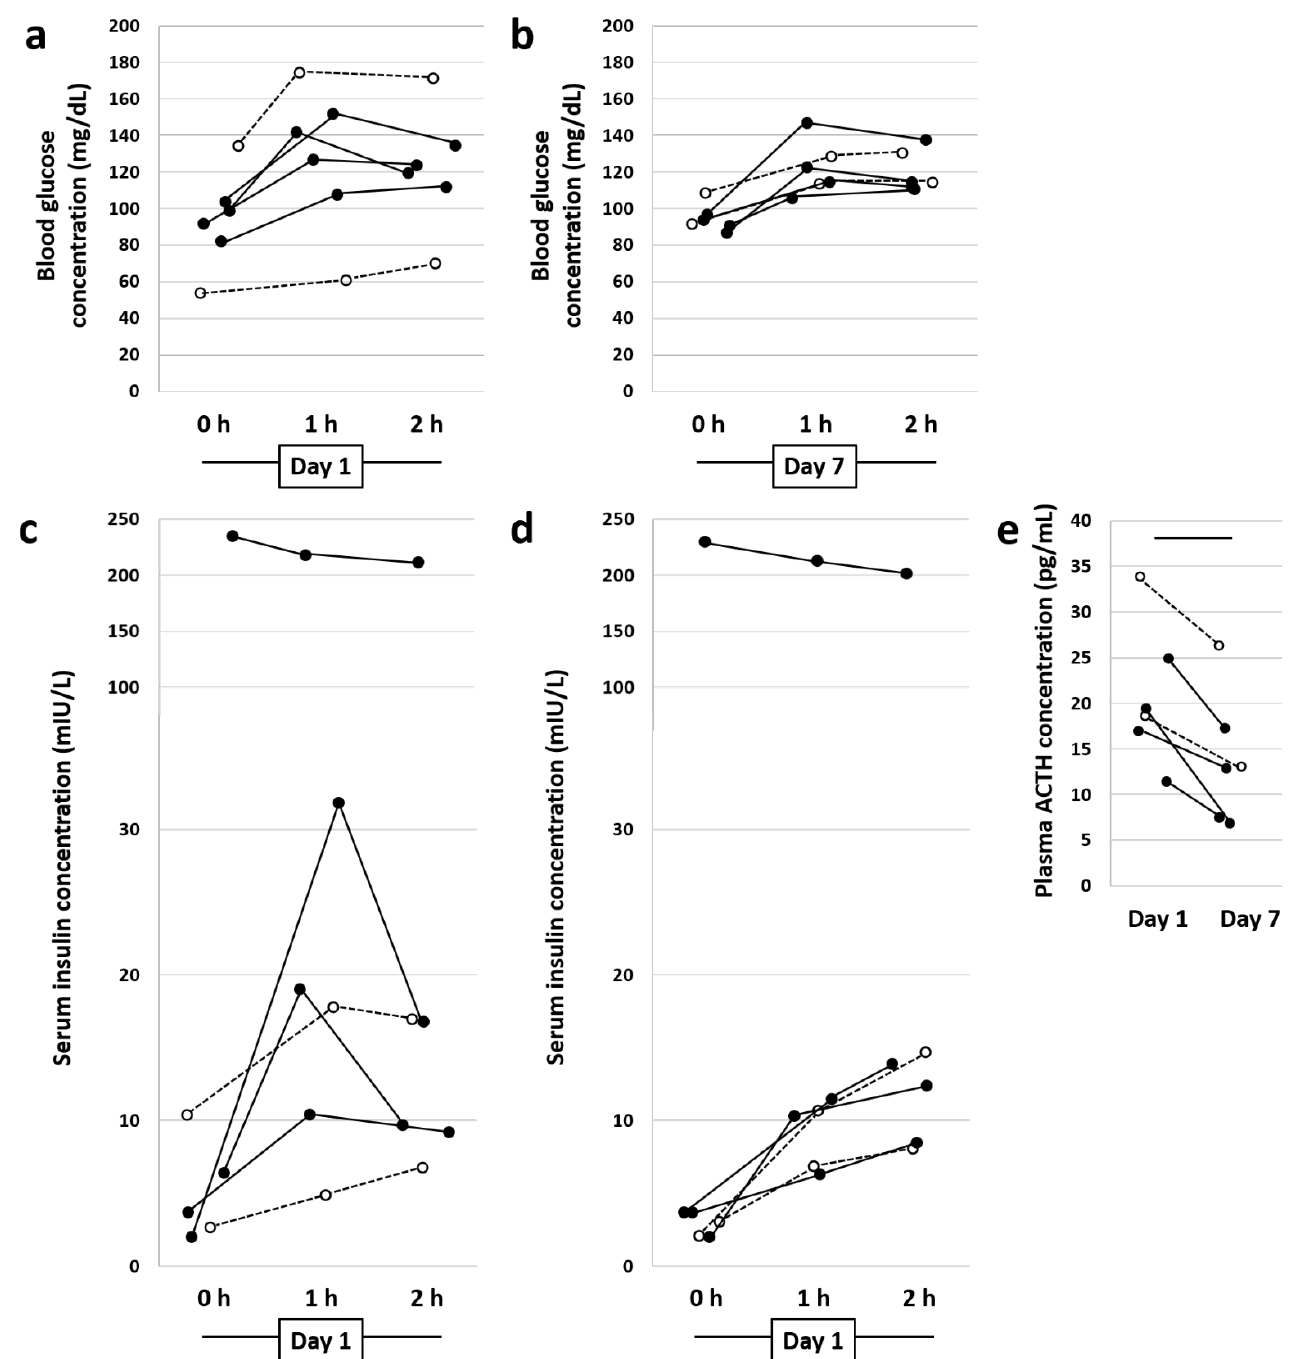
Figure 1. Results of bloodwork. Dot plots showing blood glucose levels (mg/dL) at 0 h (0 h), 1 h, and 2 h on Day 1 ( a ) and Day 7 ( b ) of the metformin treatment; serum insulin levels (mIU/L) during an oral sugar test at 0 h, 1 h, and 2 h on Day 1 ( c ) and Day 7 ( d ) of the metformin treatment; and plasma ACTH levels (pg/mL) on Day 1 and Day 7 of the study ( e ). In all panels, closed circles represent horses receiving metformin ( n = 4) and open circles represent metformin controls that were also switched to an all-hay diet ( n = 2). Bar indicates p < 0.05, paired t-test.